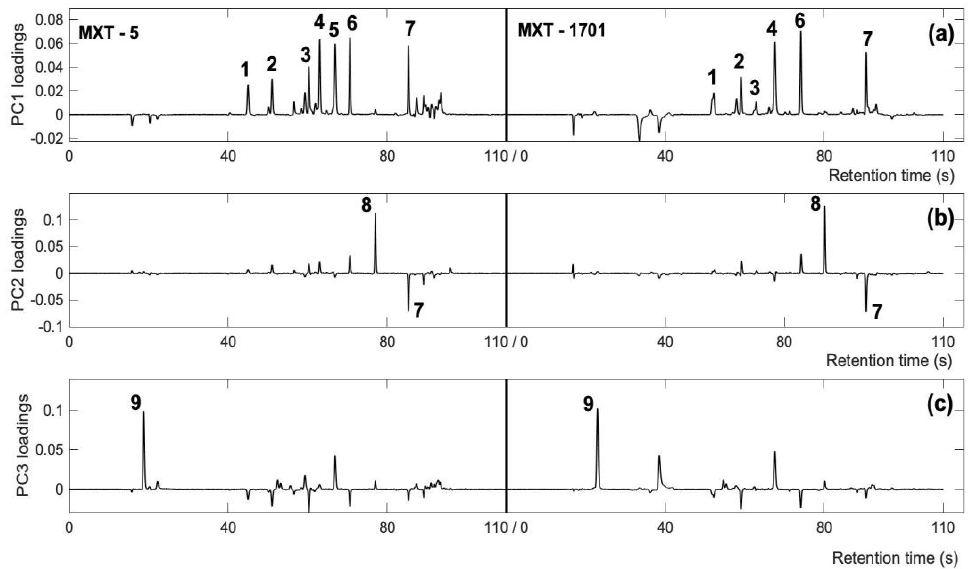
Figure 3. ( a ) PC1, ( b ) PC2 and ( c ) PC3 loading plots. Numbered peaks correspond to the volatile compounds putatively identified on the basis of Kovats’s relative retention indices: (1) compounds putatively identified on the basis of Kovats’ s relative retention indices: (1) hexanal, (2) 2-hexanal, (3) 5-methylfurfural, (4) myrcene, (5) eucalyptol, (6) linalool, (7) β -caryophyllene, and (8) eugenol (9) not identified.